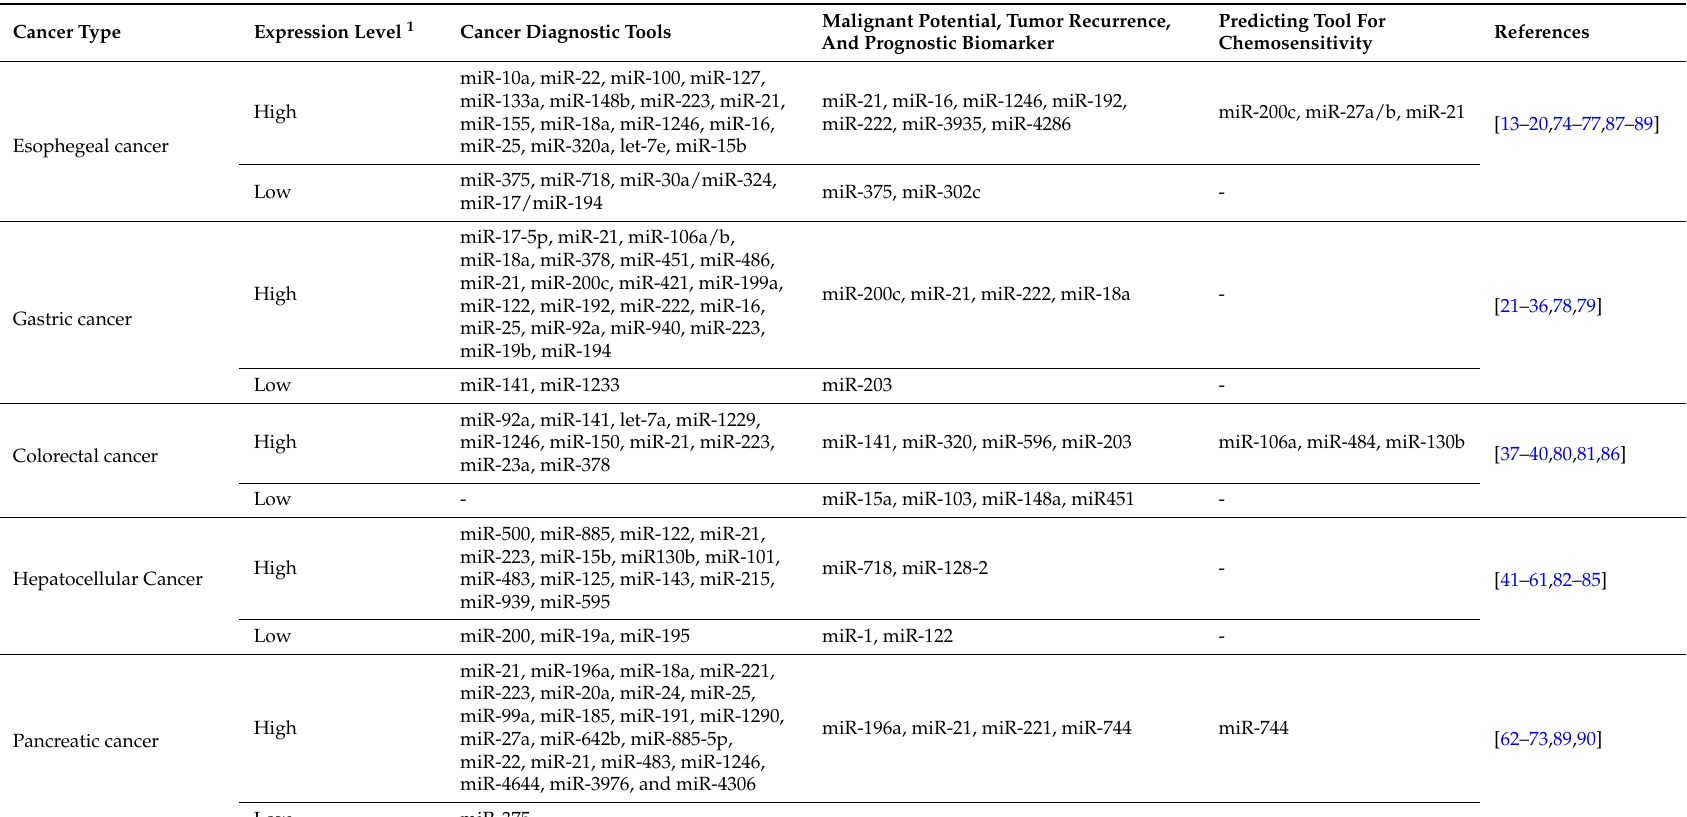
Table 1. Candidates of circulating microRNAs as cancer